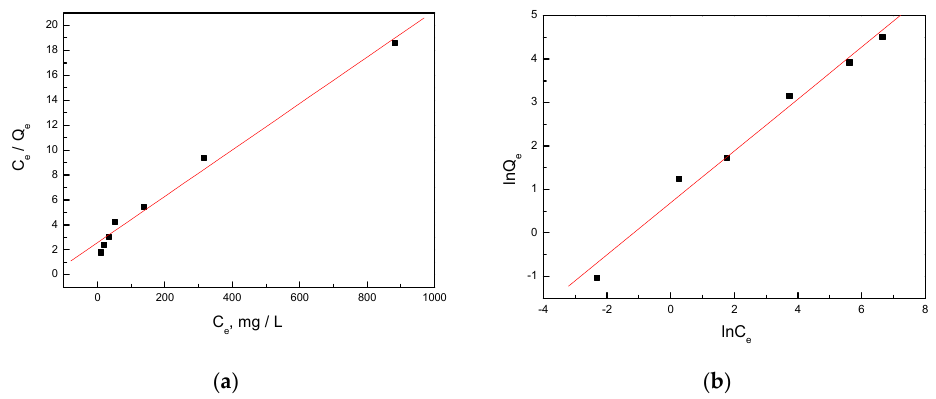
Figure 7. Effect of initial concentration on the removal efficiency for mercury ions.